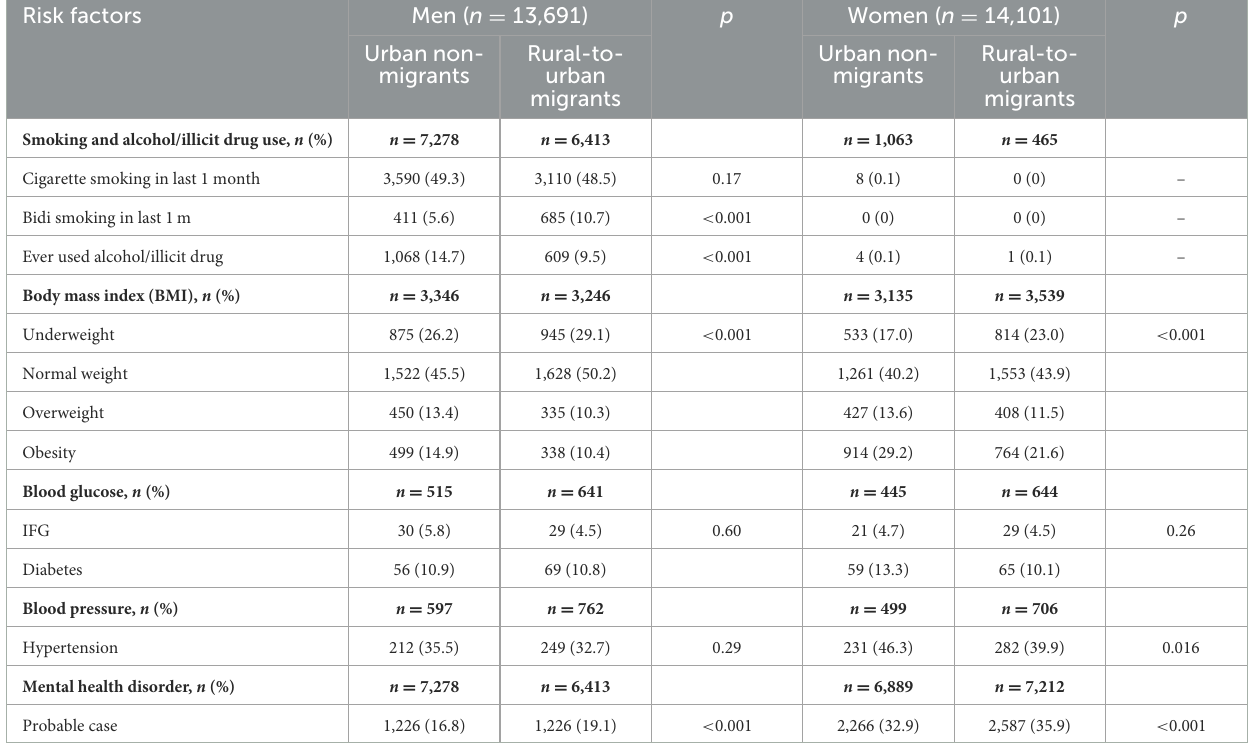
Urban non- Rural-to- migrants urban migrants